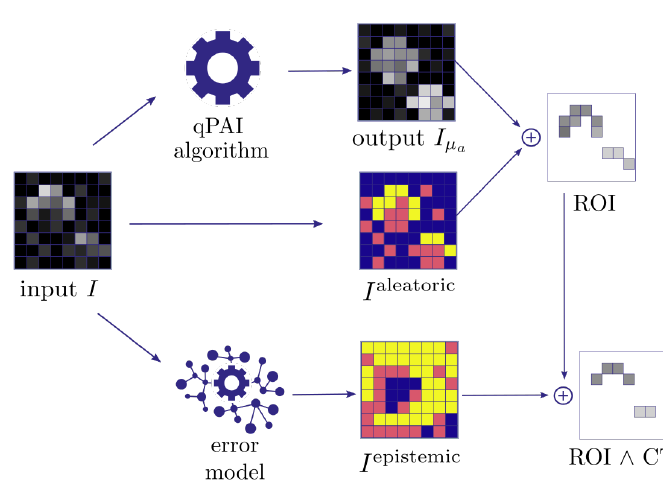
Figure 1. Visualization of the proposed method for confidence estimation using an observing neural network as an error model. The estimator generates an output for a given input and the error model is used to obtain an estimate of the quantification error from the same input data. The region of interest (ROI), which is based on the aleatoric uncertainty I aleatoric extracted from the input data, can then be refined using the error estimates I epistemic of the error model as a confidence threshold ( CT